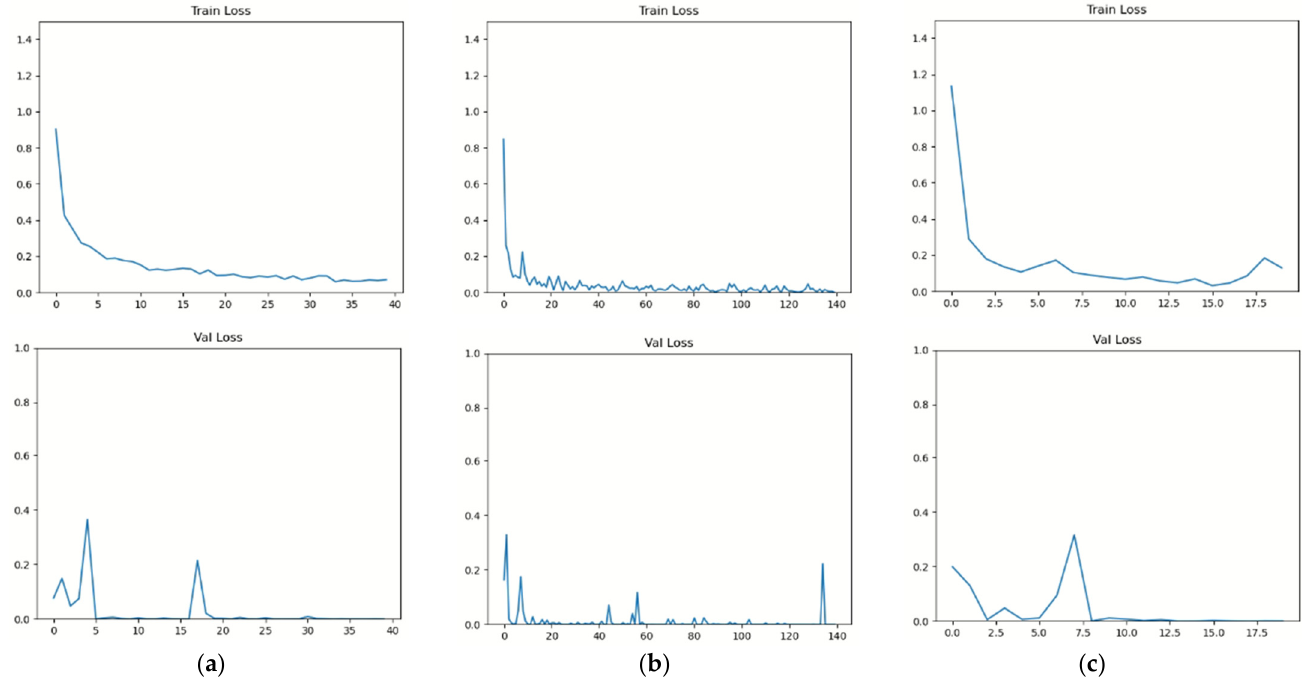
Figure 7. Train loss graph: ( a ) accelerometer and skeleton image with ResNet10+CNN+CBAM, ( b ) skeleton coordinates and accelerometer with Bi-LSTM+CNN+CBAM, and ( c ) accelerometer, skeleton vector, and skeleton image with the ResNet10+ Bi-LSTM+CNN+CBAM model.